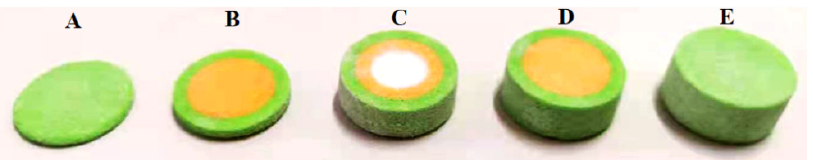
Figure 4. Structure diagram for the 3D-printed compound LEV-PN multicompartmental structured dispersible tablet. ( A ): 1–7 layers; ( B ): 1–13 layers; ( C ): 1–38 layers; ( D ): 1–44 layers; ( E ): 1–50 layers.